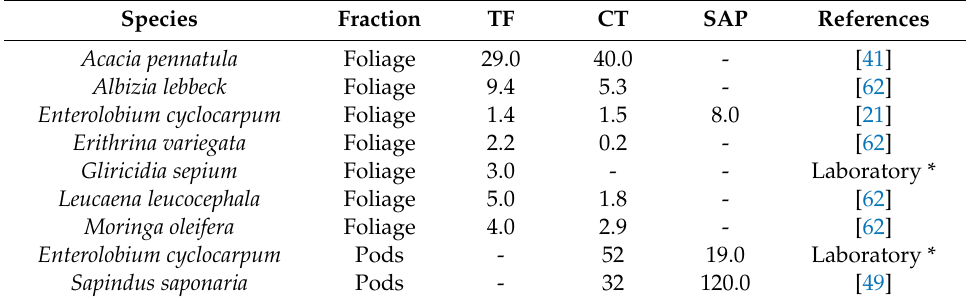
Table 2. Concentration of the main secondary metabolites in foliage of tropical trees (g / kg DM). Species Fraction TF CT SAP Acacia pennatula Foliage Albizia lebbeck Foliage Erithrina variegata Foliage Gliricidia sepium Foliage 3.0 Leucaena leucocephala Foliage Moringa oleifera Foliage Enterolobium